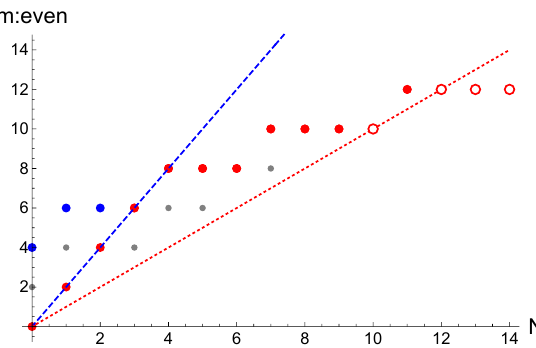
Figure 7 . The maximum values of m in the 2 N < m sector (blue circles), de(cid:12)ned by the con- straint (4.39), and in the N < m (cid:20) 2 N sector (red and red empty circles), de(cid:12)ned by the positivity of eq. (4.54). The blue dashed and red dotted curves denote m = 2 N and m = N , respectively. Branches in each sector should be above each curve. The maximum values below m = N (which can not be realized physically) are shown by red empty circles. Gray dots denote possible branches below the